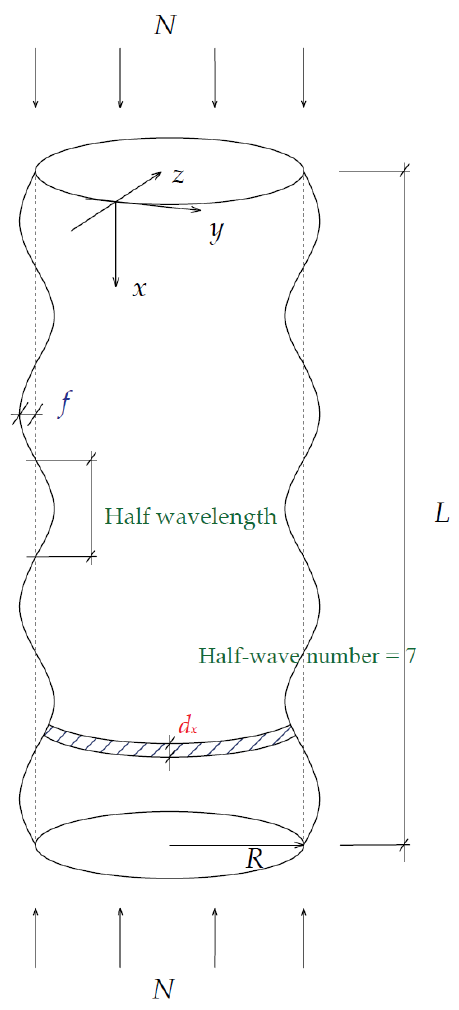
Figure 5. Assumed basic buckling shell deformation function under axial compressive load. Figure 5 represents a typical surface displacement conformed by periodic functions with a half-wavenumber equal to 7; based on which then the circumferential deflection